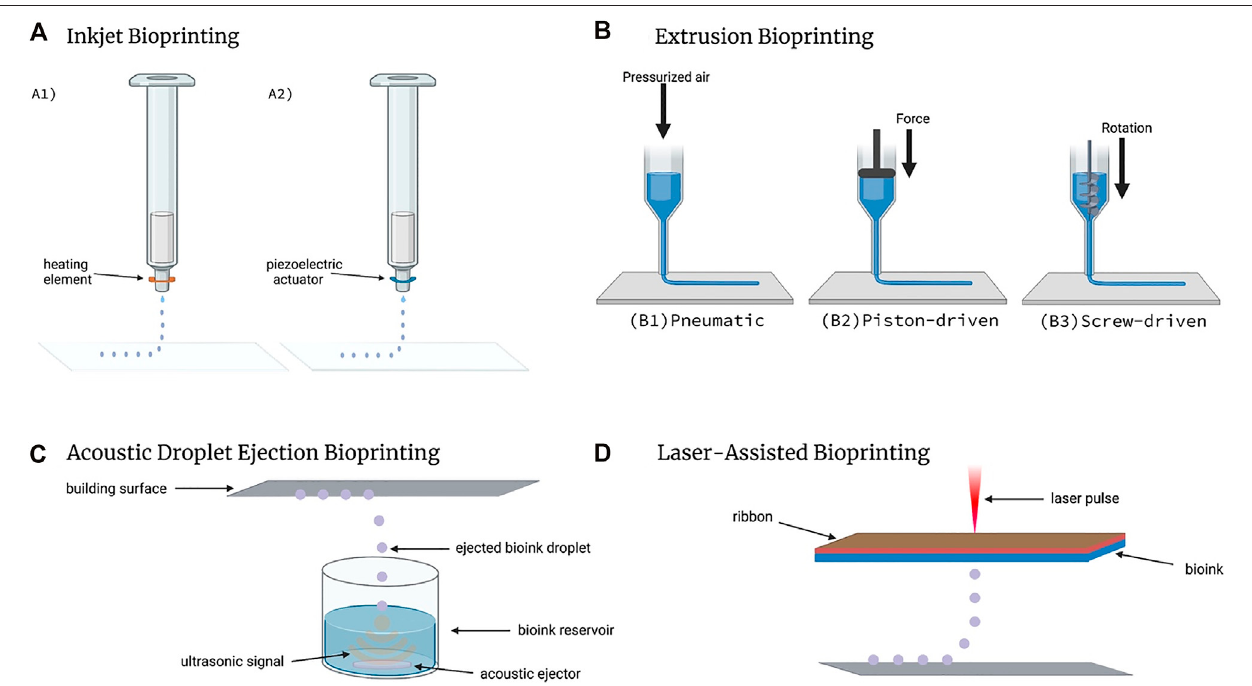
FIGURE 1 | Types of Bioprinting. (A) Inkjet bioprinters create droplets through the use of A1) a heating element or A2) a piezoelectric actuator. (B) Extrusion bioprinters come in three unique con fi gurations: B1) pneumatic, B2) piston-driven, and B3) screw-driven. (C) Acoustic Droplet Ejection bioprinting utilizes ultrasonic signals to eject bioink droplets onto the building surface. (D) Laser-assisted bioprinters deposit bioink droplets onto the building surface with each laser pulse. Created with BioRender.com.